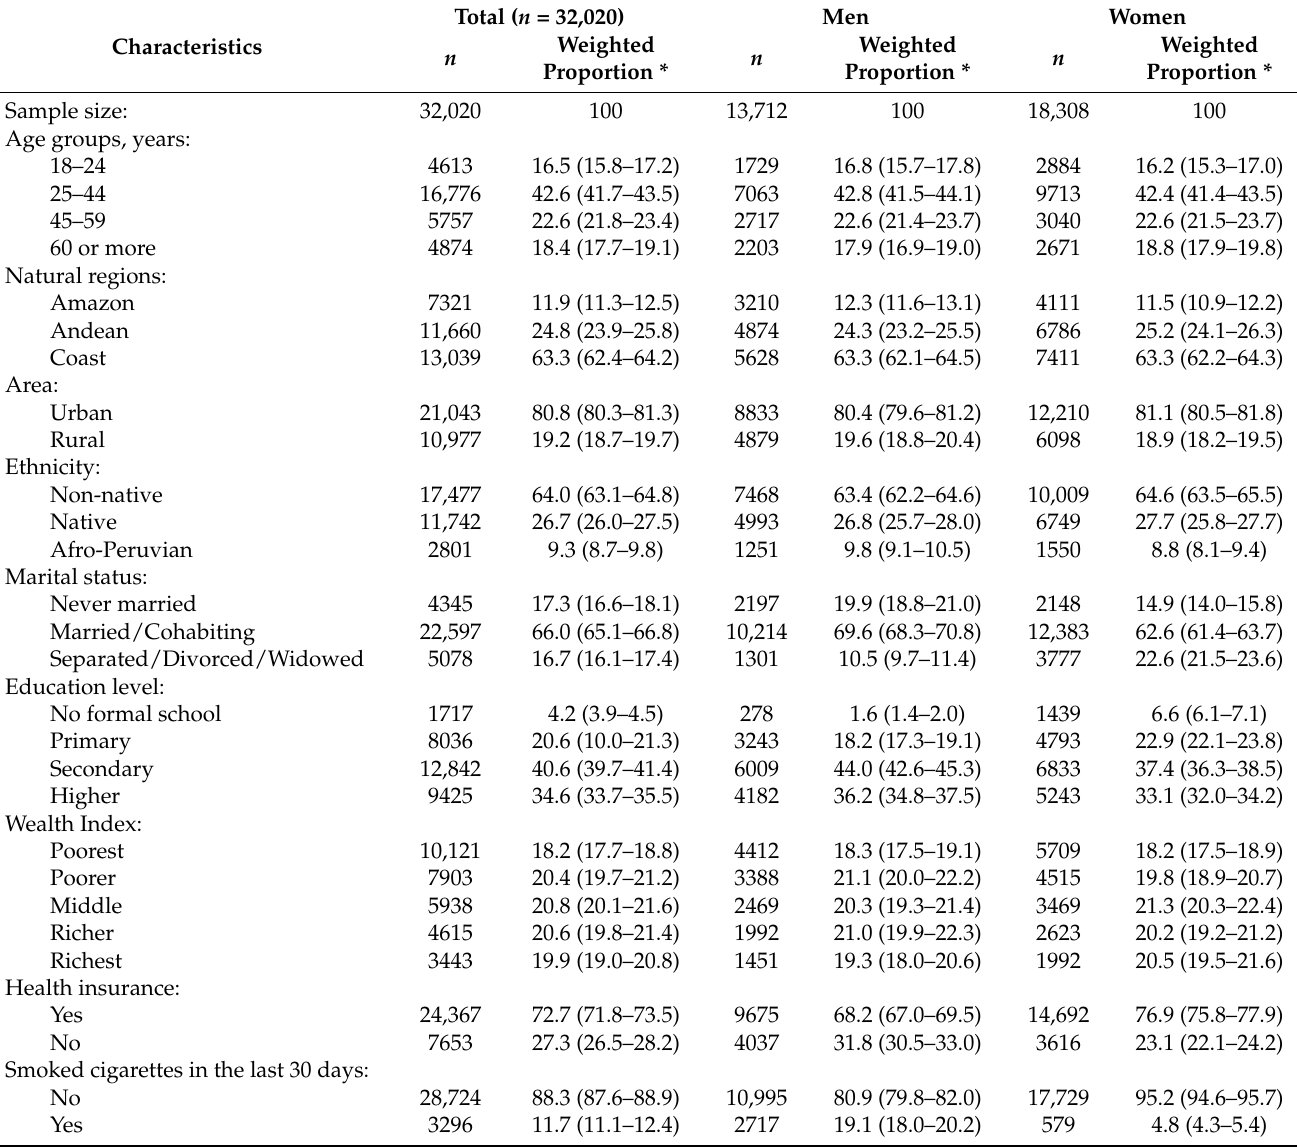
Table 1. Background characteristics of respondents by gender ( n =